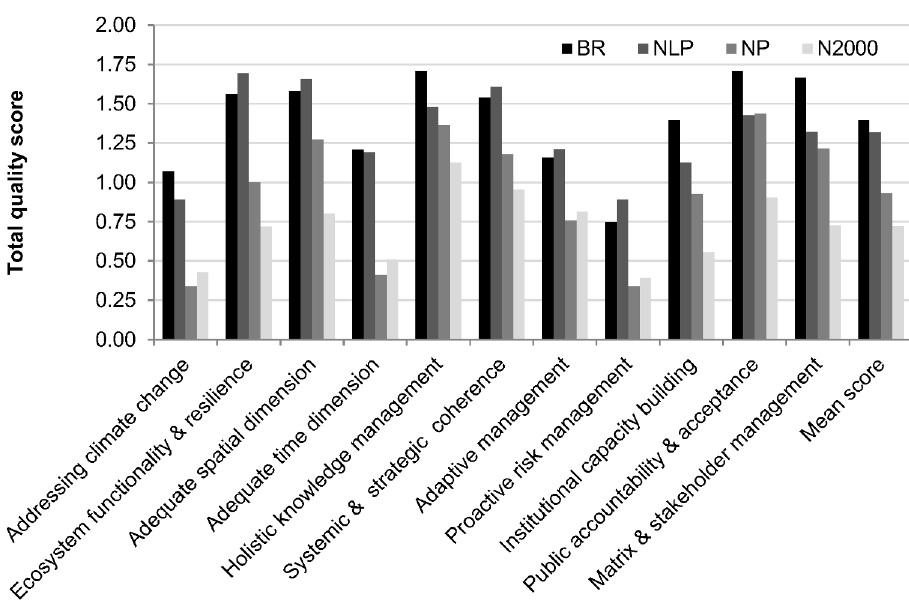
Fig 6. Total quality scores for the principles of climate change-robust conservation management sorted by protected area category. BR = biosphere reserves, NLP = nationalparks, NP = nature parks, N2000= Natura 2000